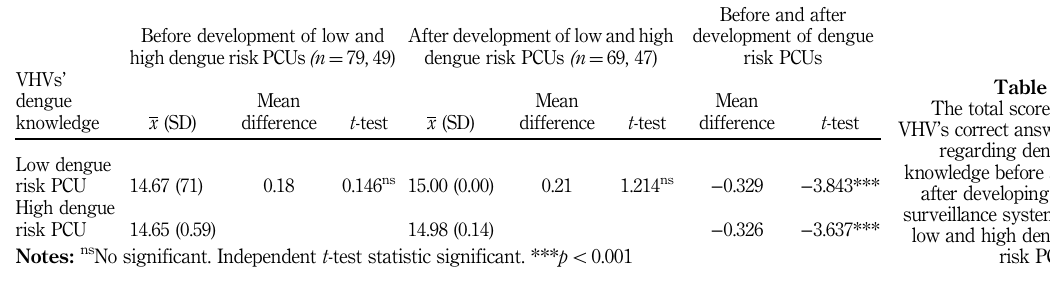
Table III. The total scores